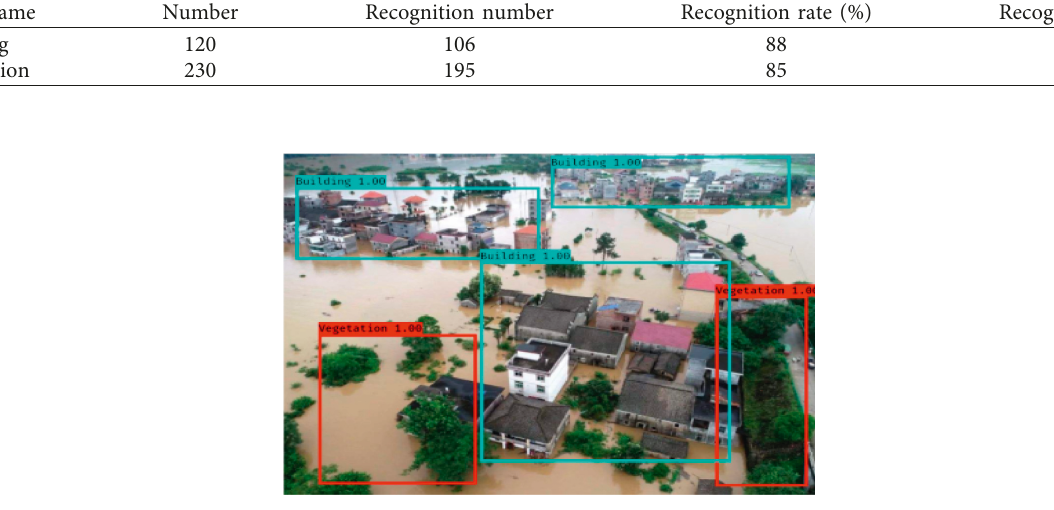
Figure 12: Example of flooded building area